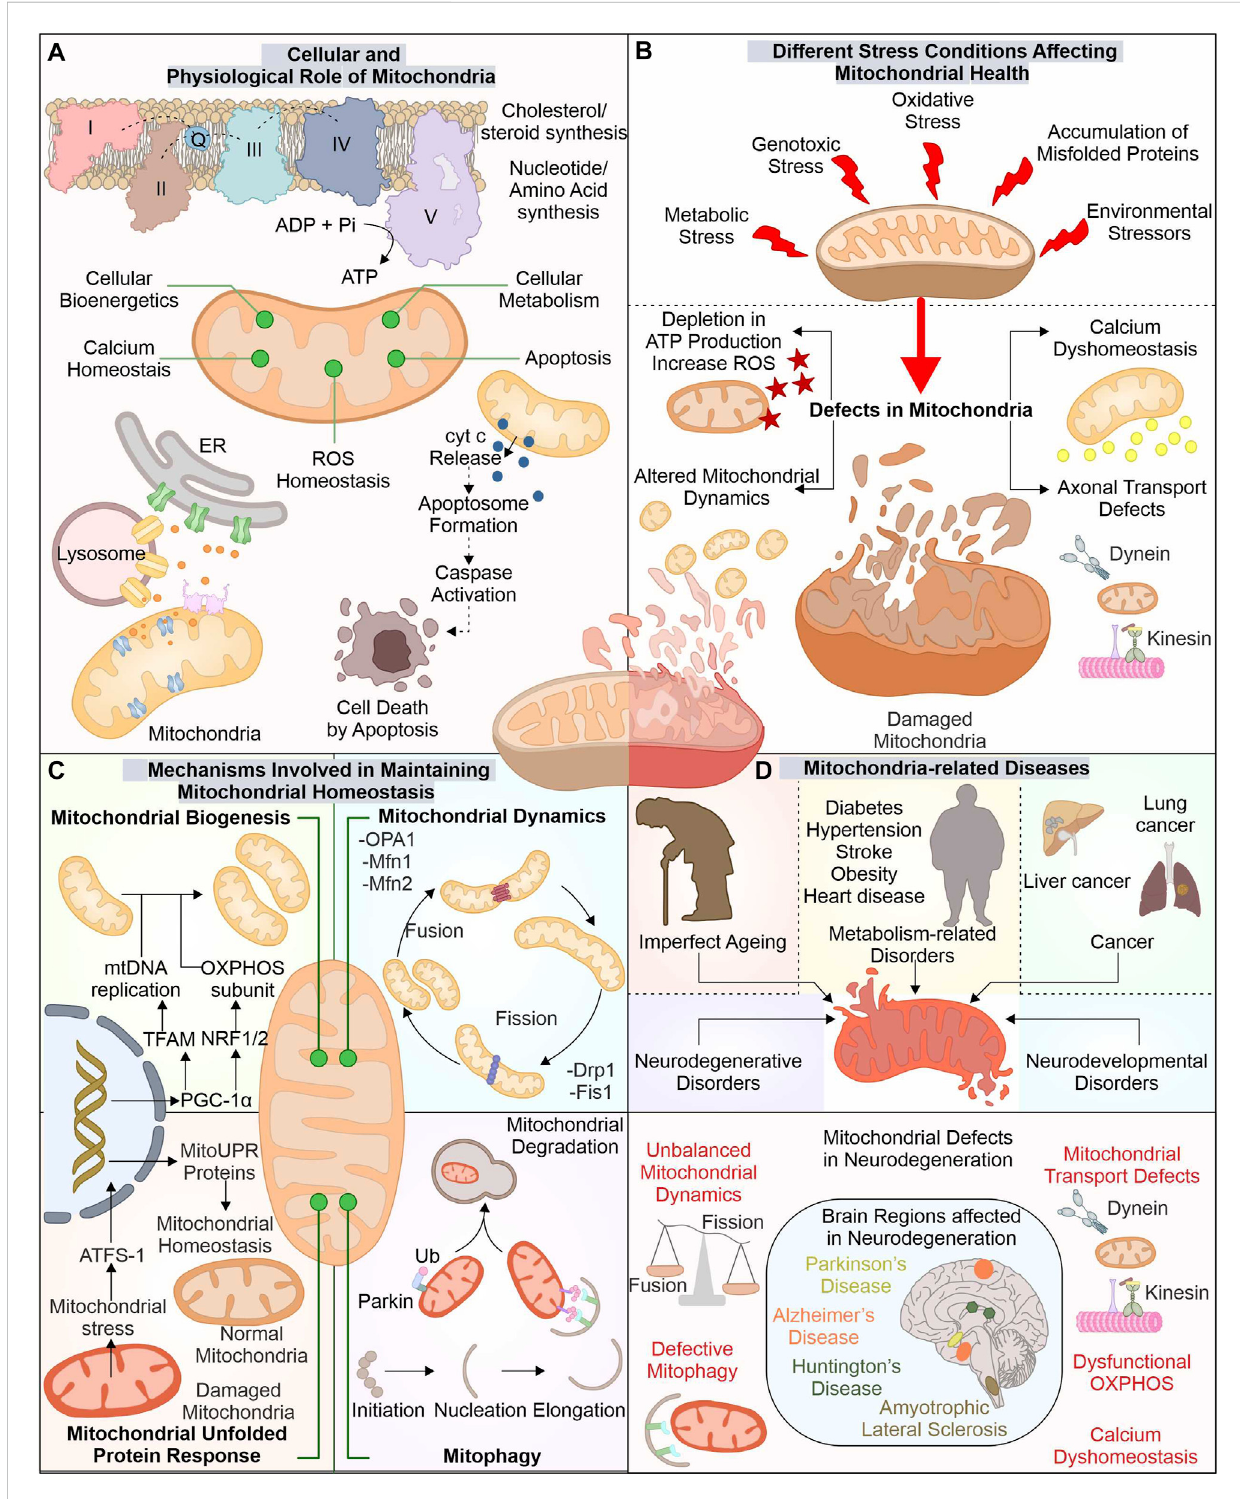
FIGURE 1 Mitochondria: The key player in cellular function and its implication in diverse diseases. Besides producing ATP for numerous cellular pathways, mitochondria also regulate ROS and calcium levels, synthesize several biomolecules, and control cell death via the apoptosis pathway (A) . Different stresses affect these mitochondrial functions leading to mitochondrial dysfunction (B) . Mitochondria possess several pathways to avoid such damage by controlling the synthesis of new mitochondria, morphology, and eliminating any dysfunctional mitochondria (C) . The altered function of these mitostasis mechanisms is observed in several disease conditions, including neuronal degenerative disorders such as ALS, AD, PD, and HD (D)